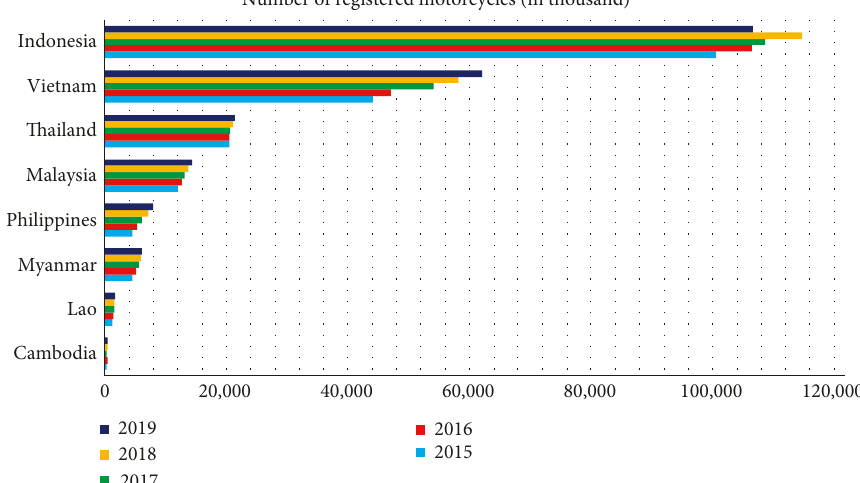
Figure 1: Number of registered motorcycles in ASEAN